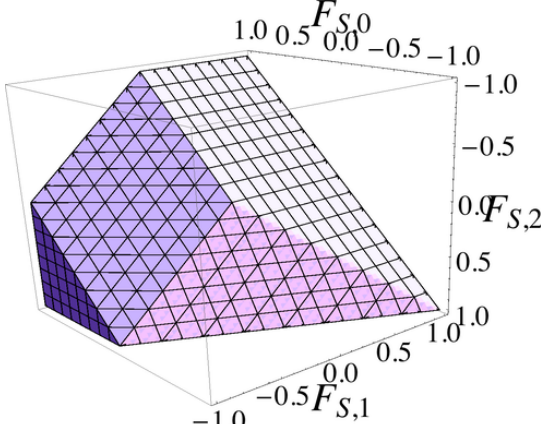
Figure 10 . Positivity bound described by M S , the linear conditions in the S -subspace. It is also the actual bound if new degrees of freedom only couple to longitudinal modes of SM gauge